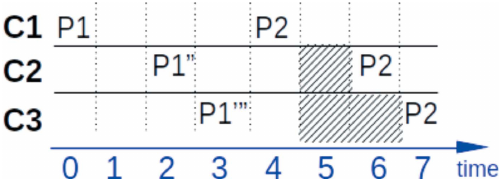
Figure 2 Example of synchronous communication and polling. Three clients at a different time start to ask for the motor’s position value with the time slot polling of 5. The first client C1 receives the final value of P2 at the t4 time while the second client C2 and the third C3 would receive this value only at time t6 and t7. Until the t7 time all three clients see different position